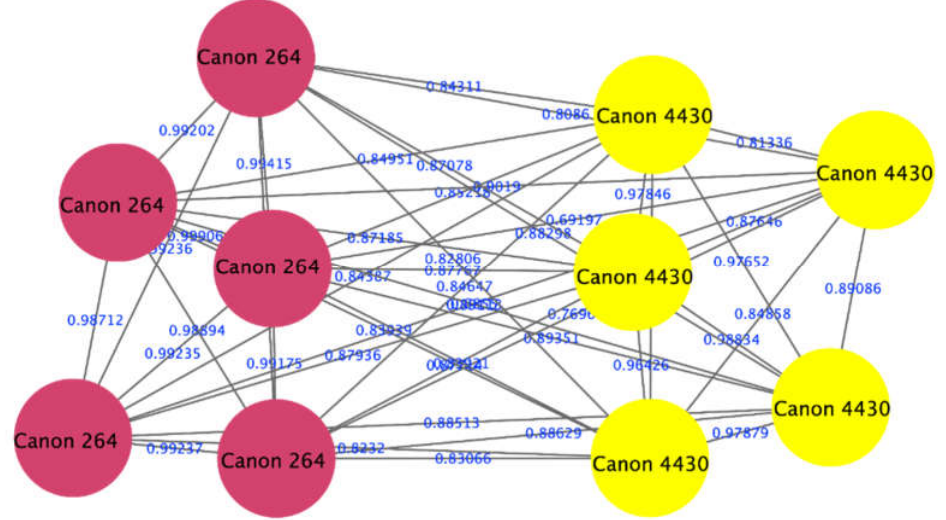
Figure 3. Visualization of the ink spectrum of the source and questioned papers printed on two separate printers: the Canon mf264 laser printer (red nodes) and the Canon 4430 laser printer (yellow nodes).